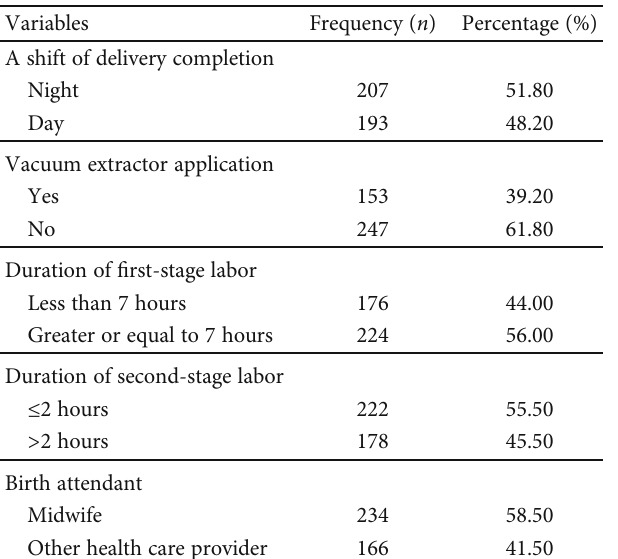
Table 4: Fetal-related characteristics of the study on magnitude and associated factors of episiotomy in Arba Minch General Hospital, Southern Ethiopia,